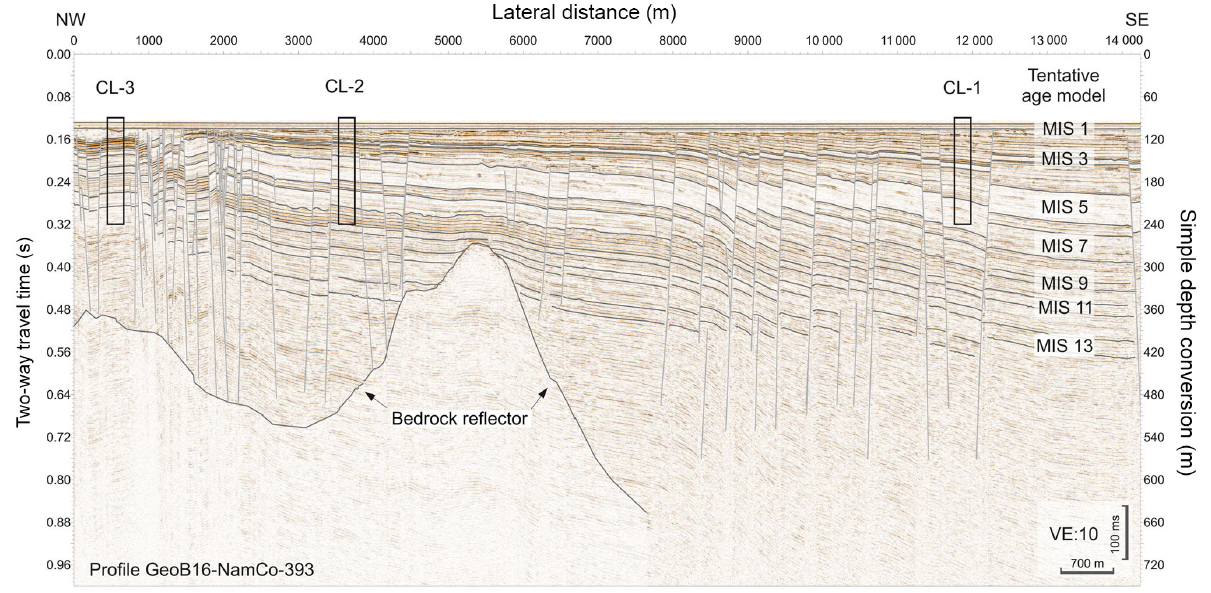
Figure 4. Multichannel seismic profile GeoB16-393 showing several hundred meters of sediment infill. Sediment thickness is increasing towards the center of the lake in the SE due to the additional subsidence of ca. 300m. Simple depth conversion with 1500ms − 1 . A tentative age model is given with marine isotope stages (MISs). Potential piston coring locations (CL-1, CL-2, CL-3) at which sediment cores can well be parallelized to form a composite sediment sequence using strong reflectors in the seismic images are indicated by black